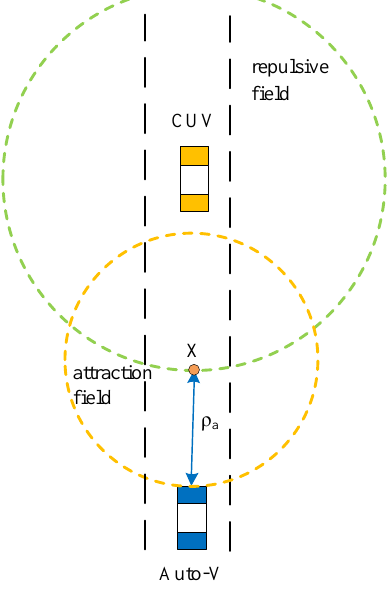
Figure 7. Autonomous vehicle affected by attraction field.